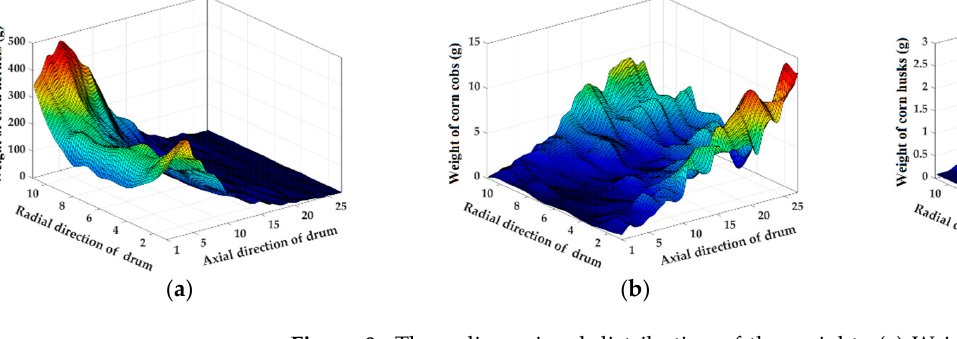
Figure 9. Three-dimensional distribution of the weight. ( a ) Weight distribution pattern of corn kernels. ( b ) Weight distribution pattern of corn cobs. ( c ) Weight distribution pattern of corn husks.